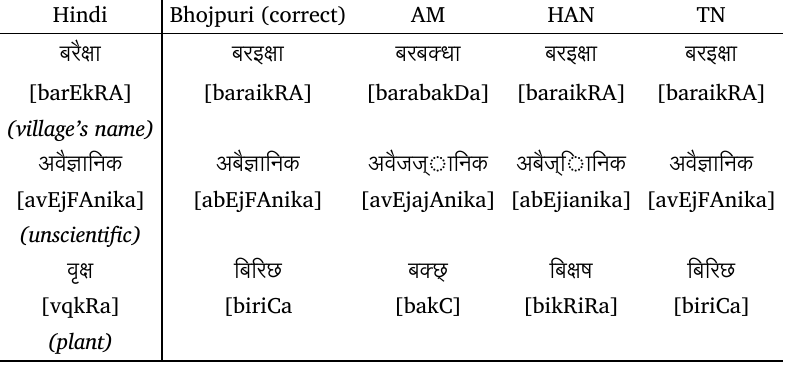
Table 9: Handling conjuncts for क्ष [kRa] and ज्ञ [jFa] Hindi Bhojpuri